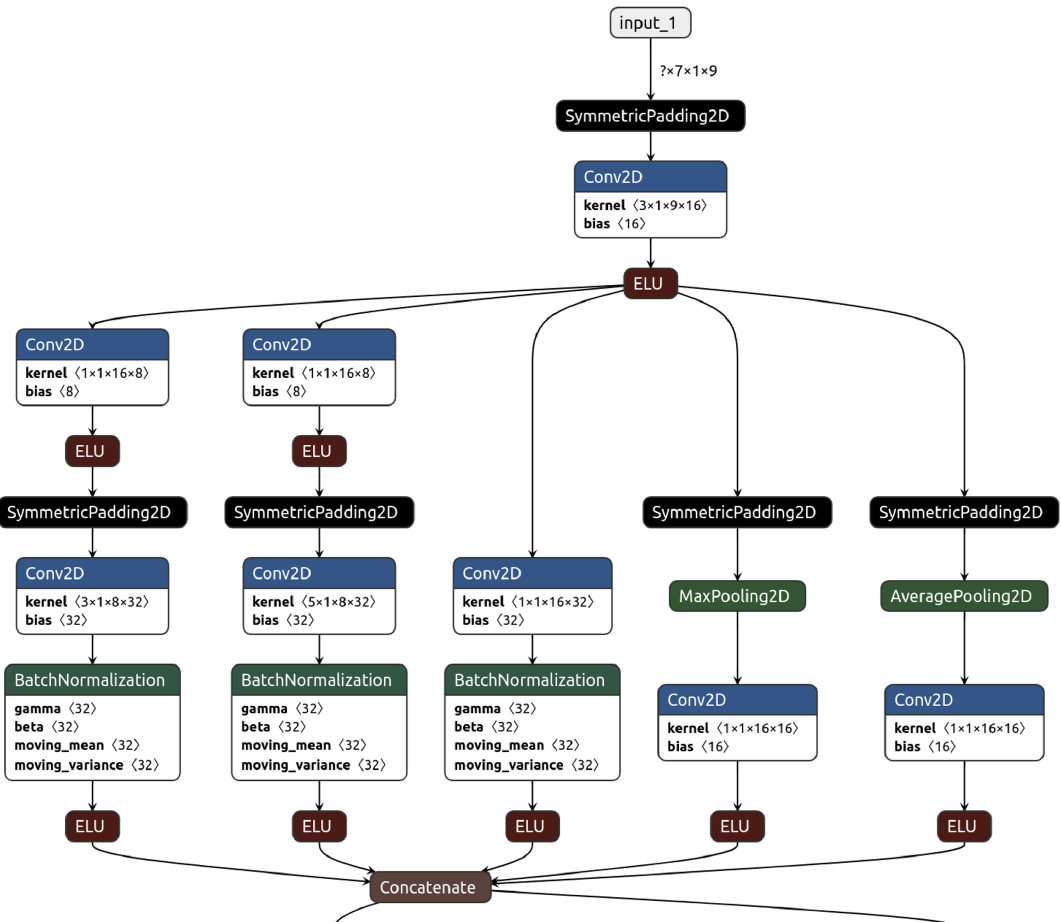
Figure A2. First part of the network showing the input, the first padding, convolution and activation, and the first inception block. This figure was created with Netron (Roeder,